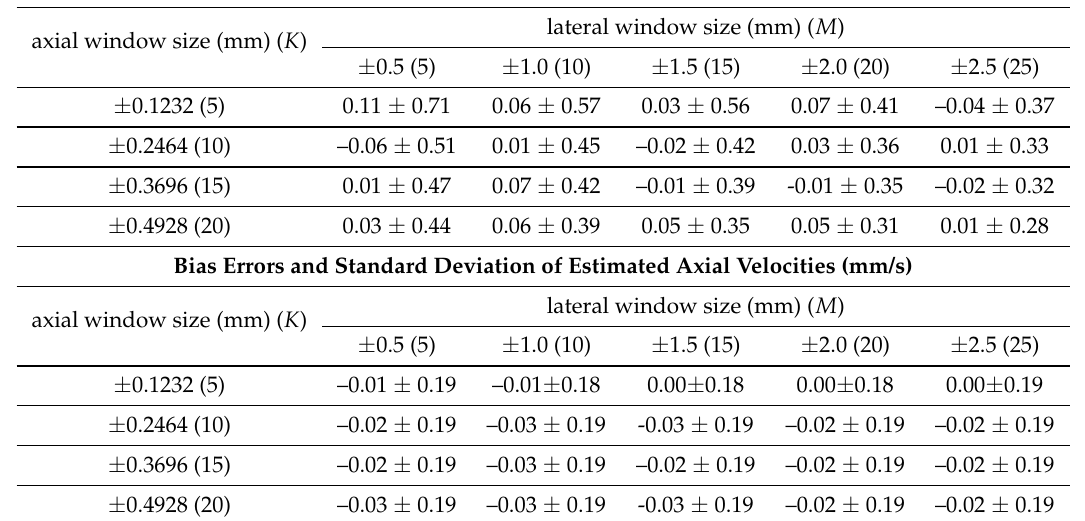
Table 8. Bias errors e bias and standard deviations σ of lateral and axial displacements at nine red points in Figure 4b estimated by the proposed 2D motion estimator with frame averaging. Beamformed echo signals were obtained with rectangular apodization. Actual lateral and axial velocities were 2 mm/s and –1 mm/s,